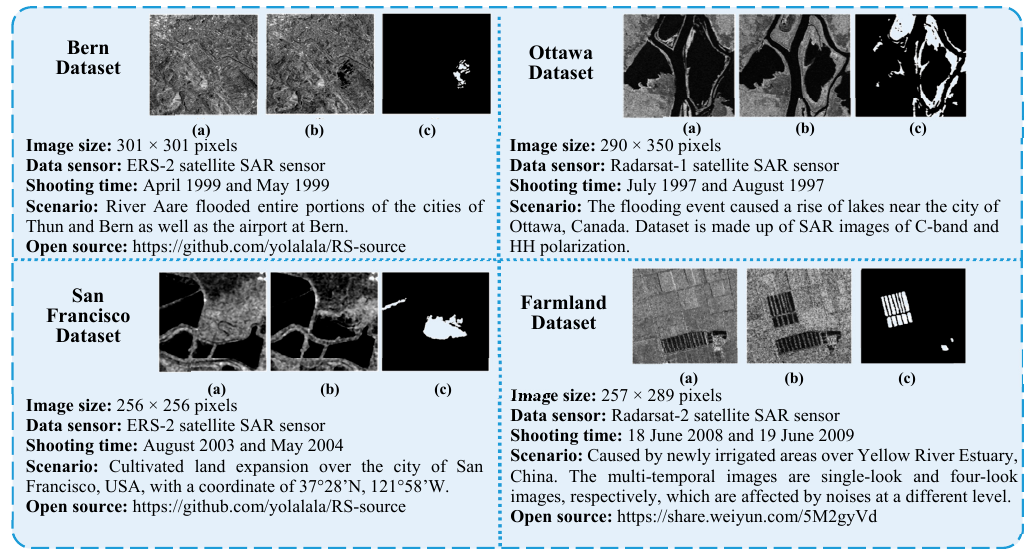
Figure 4. Dataset introduction of synthetic aperture radar (SAR) images.